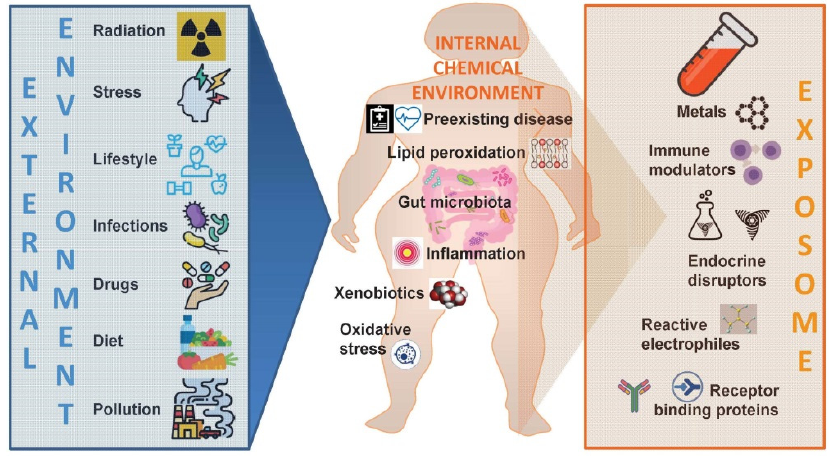
Figure 3. Characterization of the “exposome”. The “exposome” of a given person represents the combined exposures from all external sources that reach the internal chemical environment. Specific biomarkers or potential signatures of the “exposome” might be detected in the bloodstream.